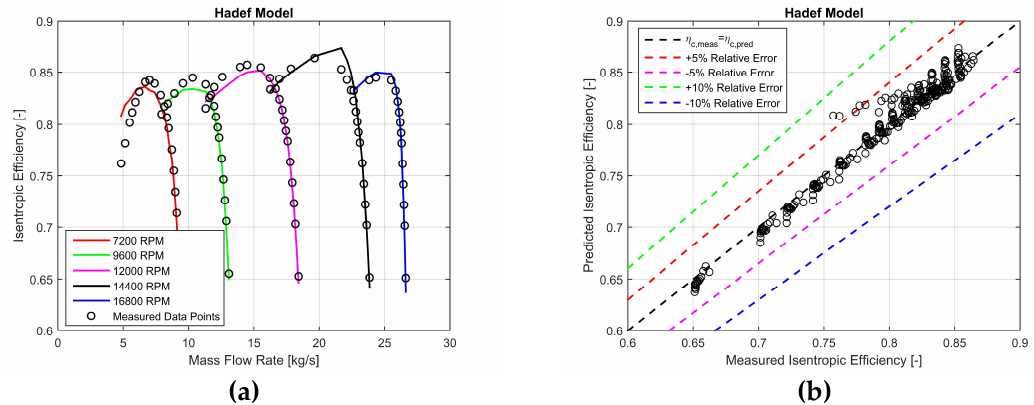
Figure 7. Predictive result and error distribution for Hadef isentropic efficiency model: ( a ) predictive result; ( b ) error distribution.